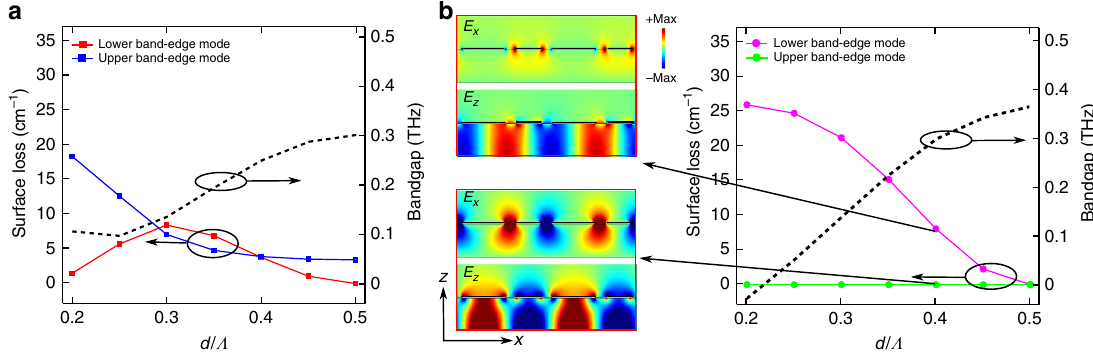
Fig. 3 Design considerations and comparison with a dual-slit second-order DFB structure. a Computed surface loss of the band-edge modes for the hybrid DFB structure shown in Fig. 2a, plotted as a function of d / Λ . Aperture spacing d is a design parameter that could be utilized to alter the respective losses and also the bandgap, which is also plotted. b Surface loss and bandgap is also plotted as a function of aperture spacing for a dual-slit second-order DFB structure (i.e., two slits are present in each grating period at the periodicity of Λ ), which has been used for terahertz QCLs previously 26 . Electric fi eld pro fi les near the center of cavities for both band-edge modes are plotted for the case of d / Λ = 0.4 as an